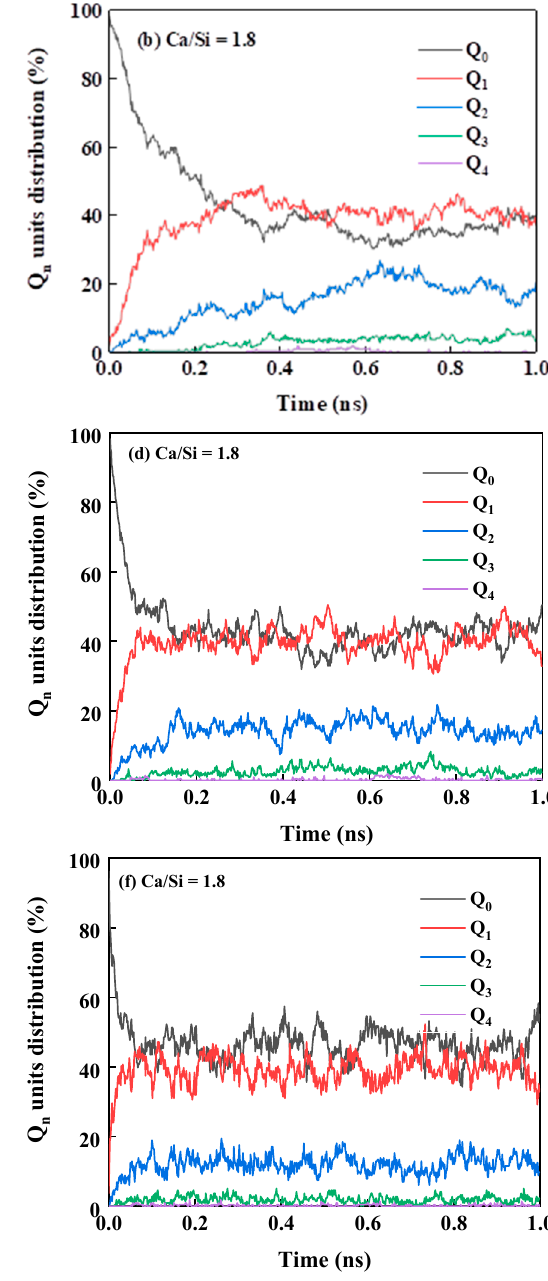
Figure 8. Content of Q n by different C/S ratios and temperatures. ( a ) C/S = 1.1, 1500 K; ( b ) C/S = 1.8, 1500 K; ( c ) C/S = 1.1, 2000 K; ( d ) C/S = 1.8, 2000 K; ( e ) C/S = 1.1, 2500 K; ( f ) C/S = 1.8, 2500 K.